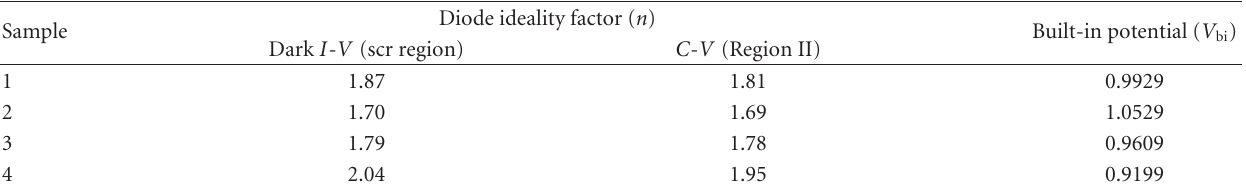
Table 5: The values of diode ideality factor ( n ) and built-in potential ( V bi ) of solar cell with di ff erent diborane flow rate of p-type layers.